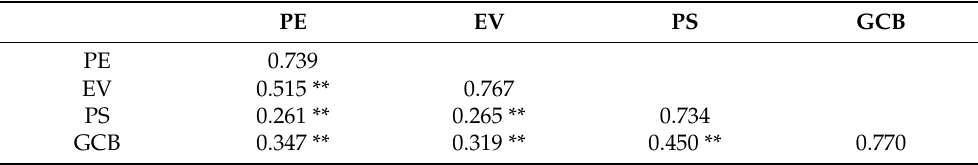
Table 3. Discriminant validity of potential variables.